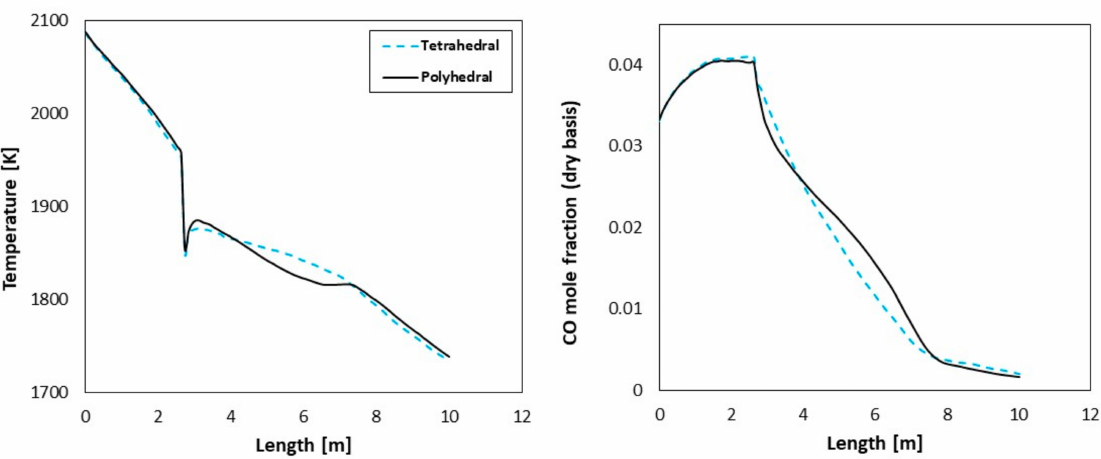
Figure 8. Predictions of different cell types for off-gas temperature and CO model fraction